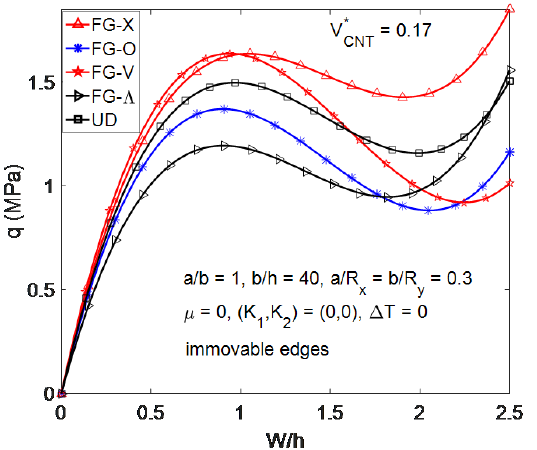
Fig. 7: Effects of curvature and CNT distribution on the extremum type buckling pressures of CNTRC spherical panels with immovable edges.